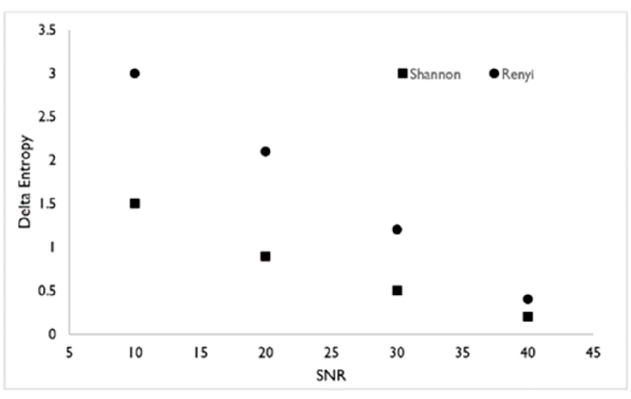
Figure A2. Delta entropy against signal-to-noise ratio (SNR) for Shannon’s and Renyi’s entropy.